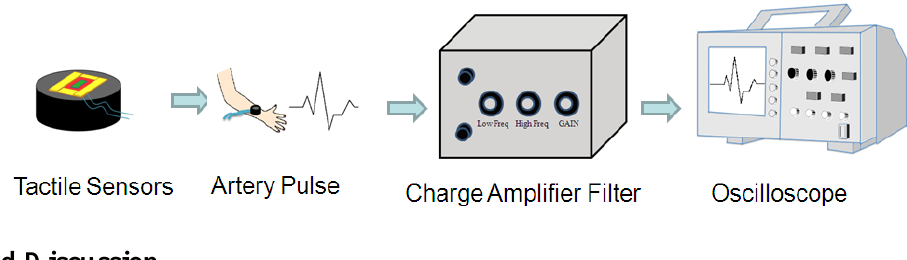
Figure 3. Experimental set-up for PZT flexible tactile sensor characterizations.